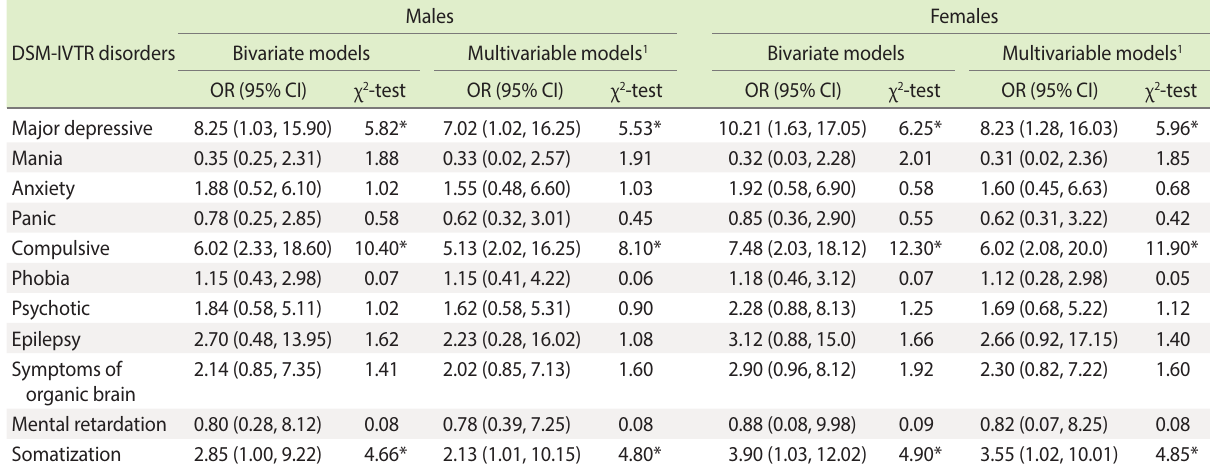
Table 3. Bivariate and multivariate associations between suicidal ideation and DSM-IVTR mental disorders by sex